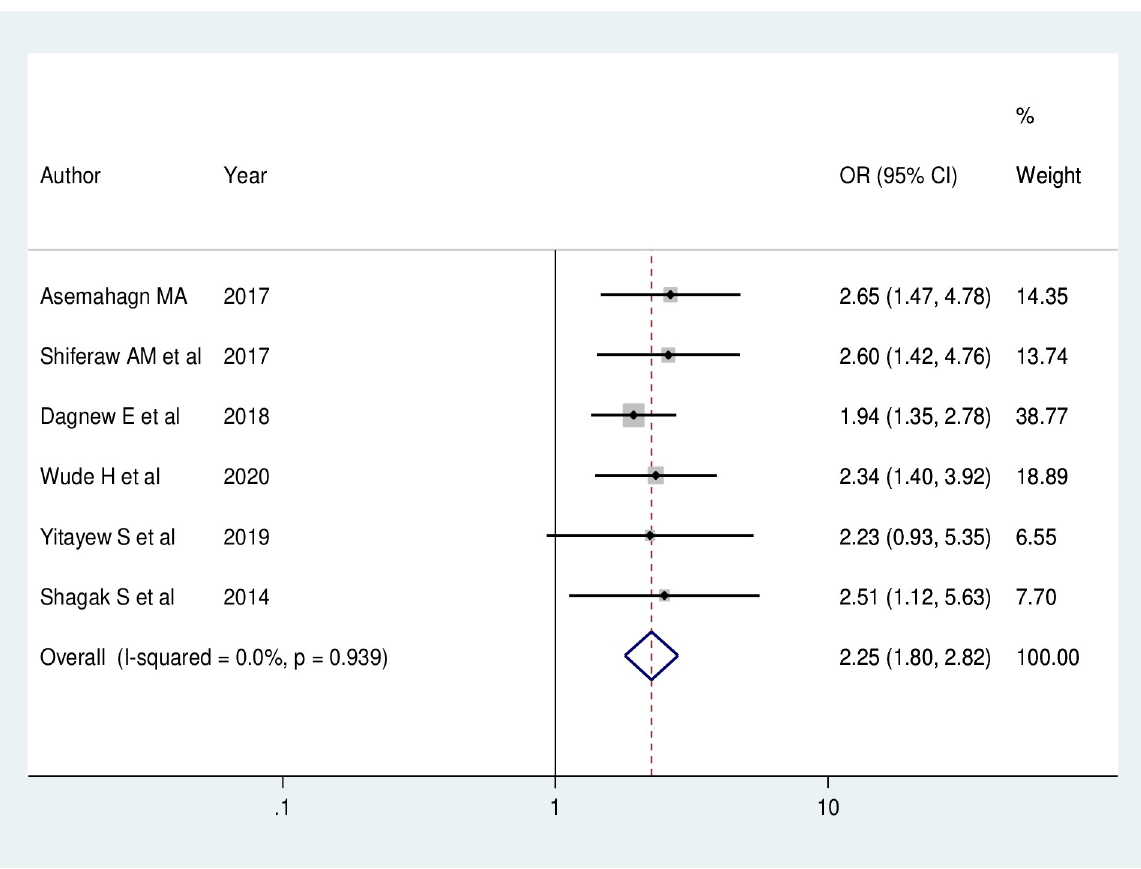
Fig 5. Forest plot showing the pooled odds ratio of the association between supportive supervision and utilization of routine health information health workers in Ethiopia, 2020.